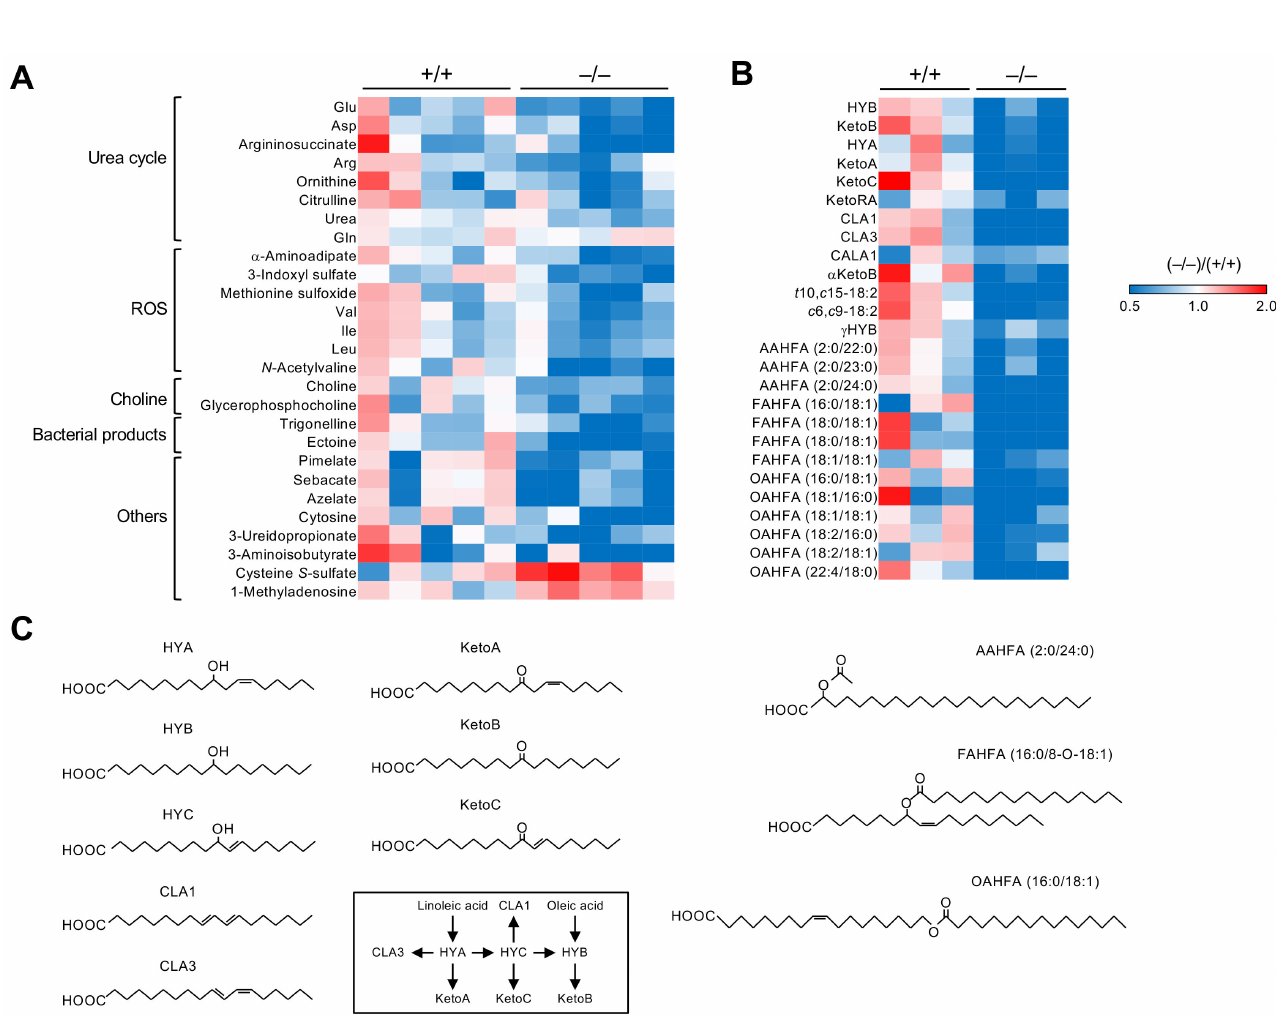
Figure 2. Alterations in the levels of plasma and fecal metabolites in Pla2g2a − / − BALB/c mice. The heatmaps indicate fold changes of hydrophilic metabolites in plasma ( A ) and bacterial lipids in stools ( B ) of individual Pla2g2a − / − mice compared to Pla2g2a +/+ mice. ( C ) Structures of representative bacterial lipids listed in ( B ). Biosynthetic routes of hydroxy-, oxo-, and conjugated linoleic acid metabolites are also shown. The mice were housed in a pathogen-free facility (TMIMS) with a 12 h light–dark cycle at 23 ◦ C, with free access to water and food, and all animal experiments were carried out according to protocols approved by the Institutional Animal Care and Use Committees under the Japanese Guide for the Care and Use of Laboratory Animals